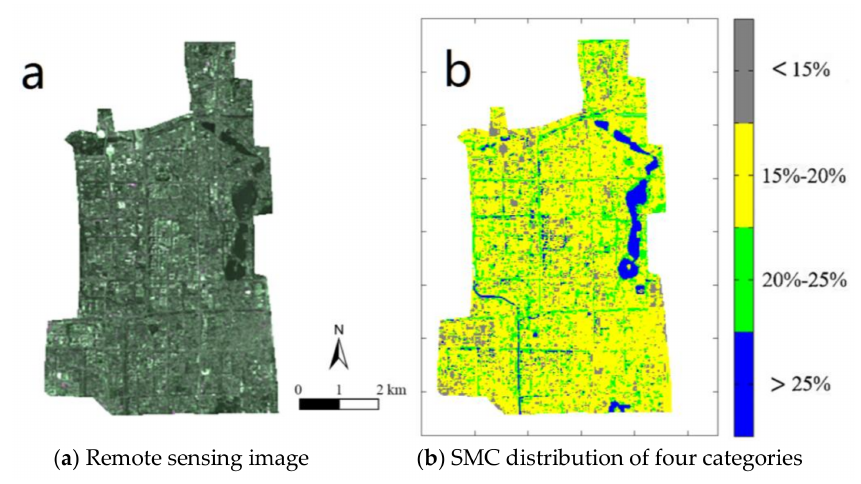
Figure 8. ( a ) The remote sensing image and ( b ) SMC distribution in the Xicheng District.